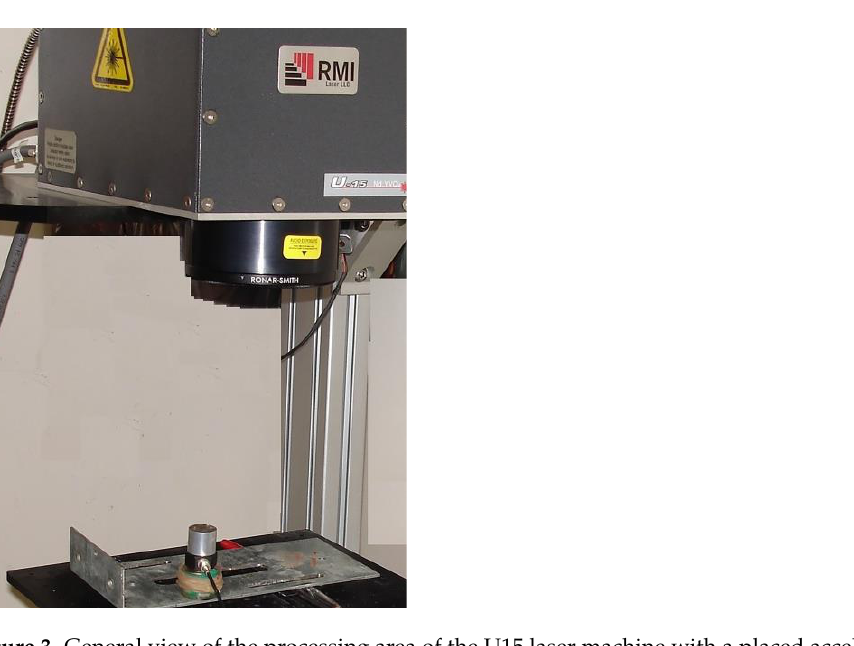
Figure 2. Processing area of the CUT 1000 machine with placed accelerometers: 1 — wire tool; 2 — workpiece; 3 — accelerometers.